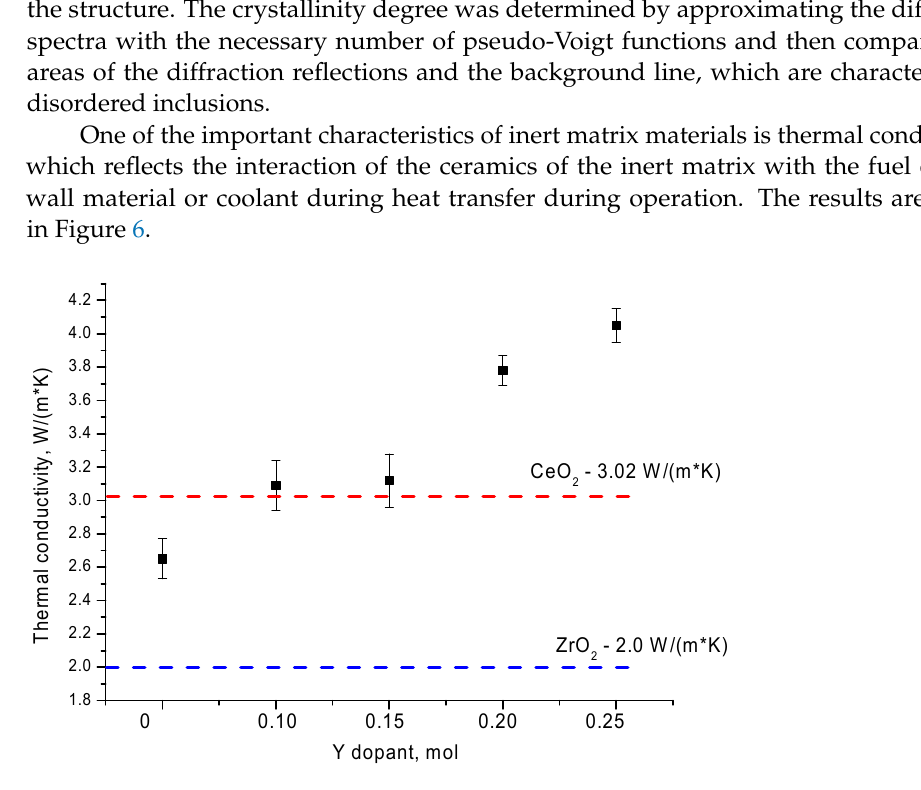
Figure 6. The results of the change in the thermal conductivity coefficient (dotted lines indicate the thermal conductivity coefficient values for ZrO 2 and CeO 2 ).